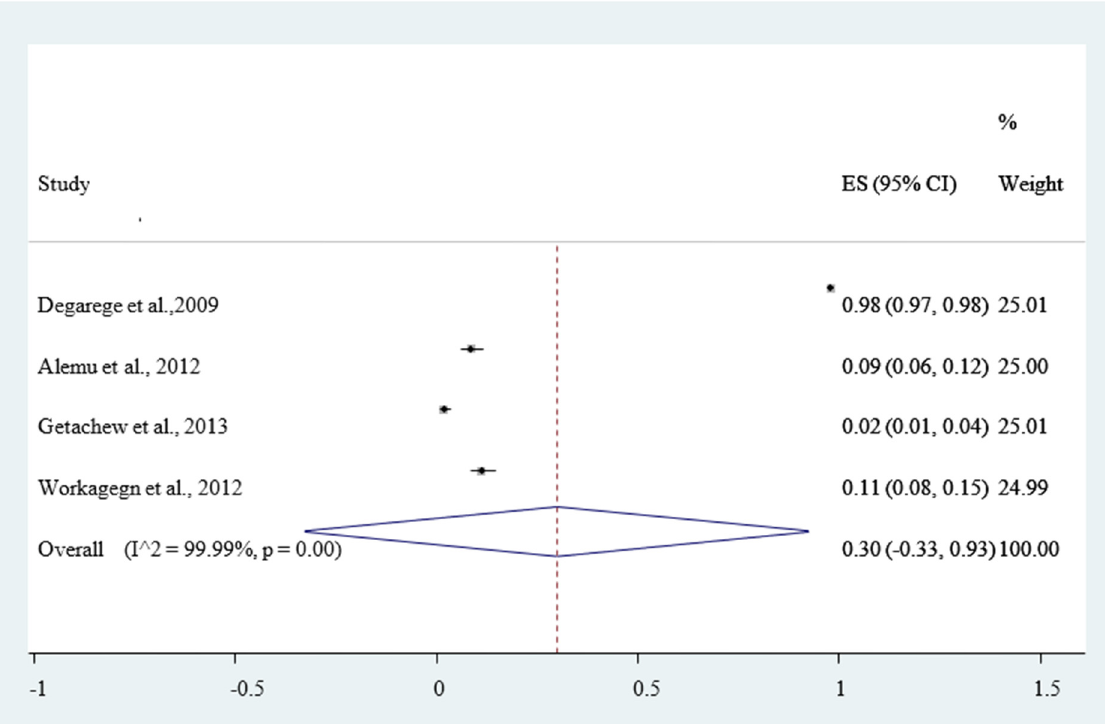
Figure 5. Forest plot of 4 studies on magnitude of Plasmodium vivax infection among out patients in Ethiopia, 2020.